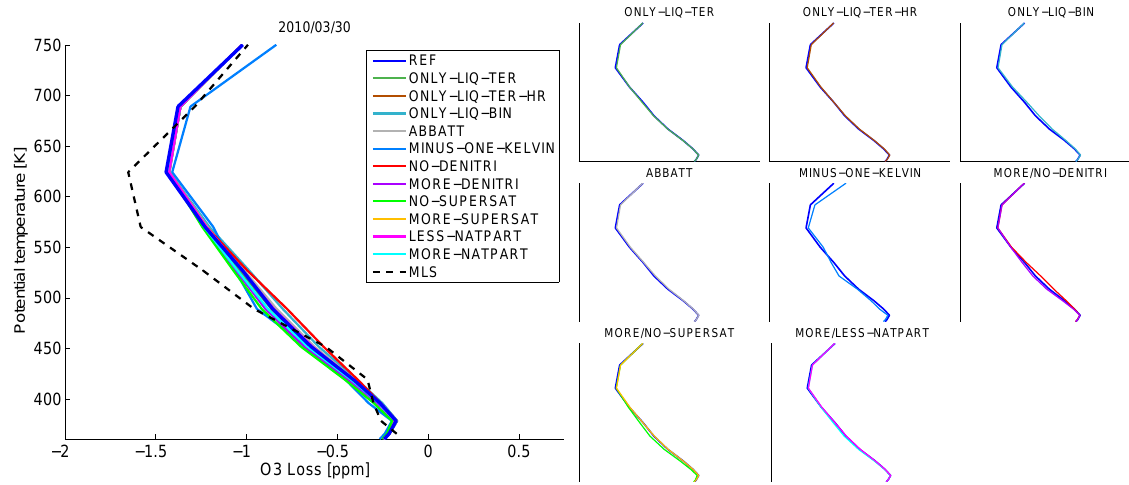
Fig. 9. Vortex-averaged cumulative ozone loss on 30 March 2010 as a function of potential temperature for all sensitivity runs and the reference run. The different sensitivity runs are represented by different colours. The black dashed line shows the corresponding ozone loss obtained by subtracting the passive ozone tracer of the model from MLS ozone measurements. Vortex average as in Fig. 1. The small plots on the right show only one or two sensitivity runs and the reference run at the same time for clarity.